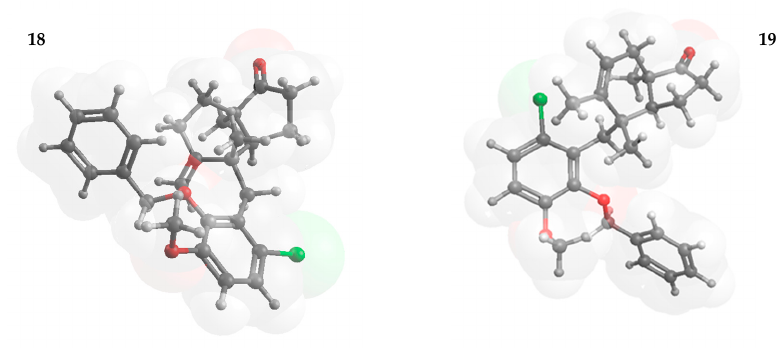
Figure 2. Computational models for complex cyclopentanones 18 and 19 suggest distinct chair conformers.